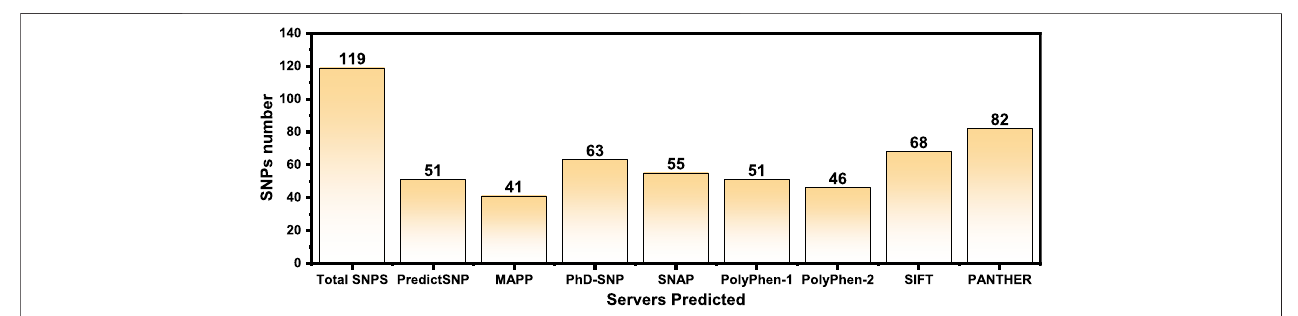
FIGURE 2 | The total number of predicted deleterious SNPs by each server is shown as bars. Each bar represents a speci fi c server, and its predicted deleterious mutations are given on the